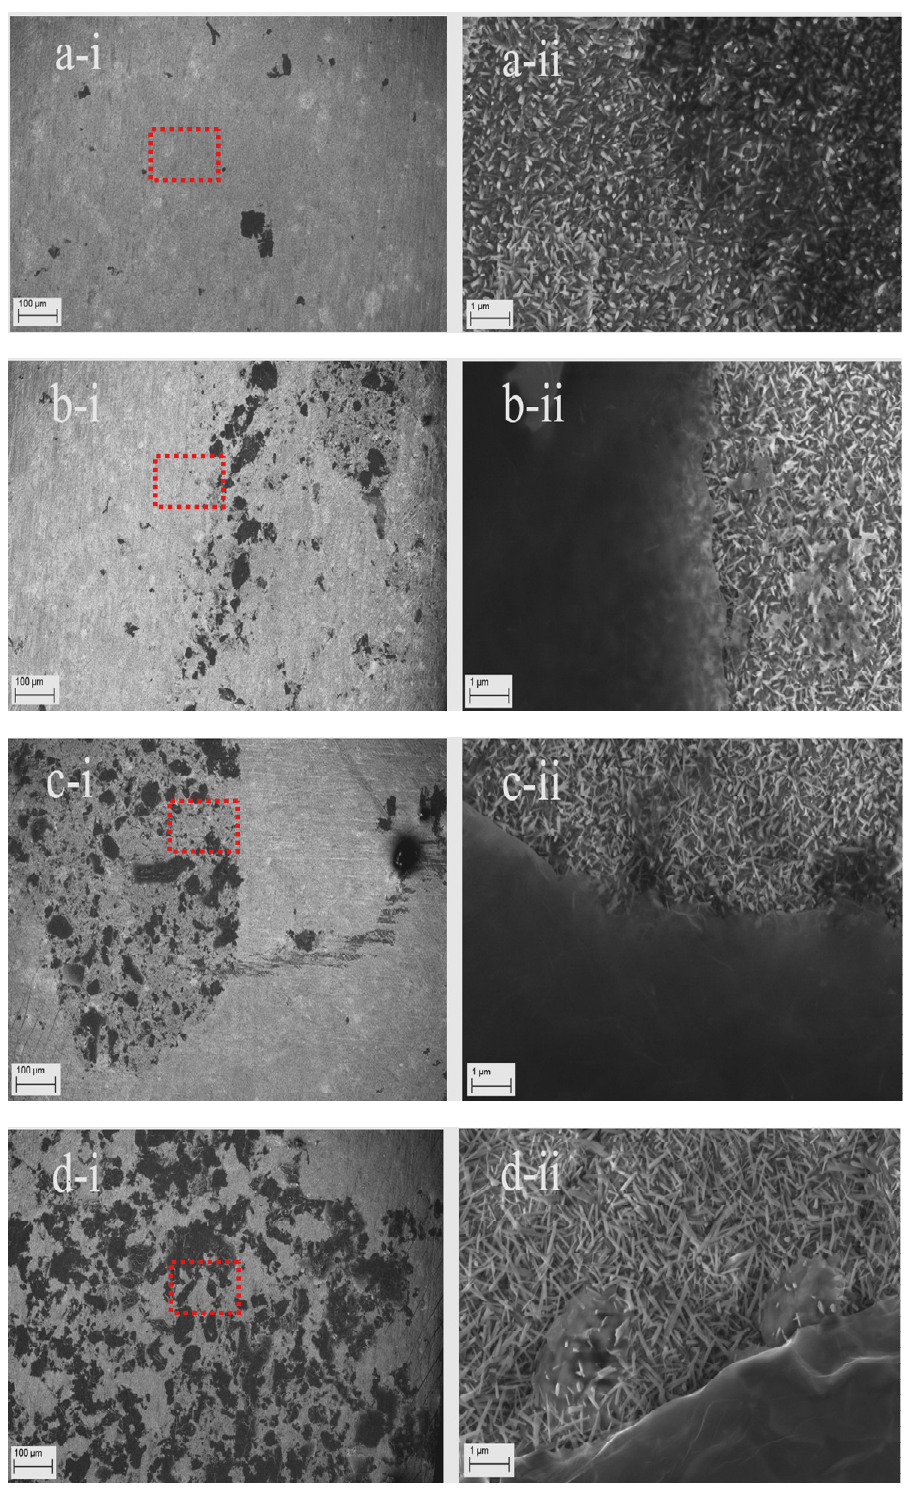
Figure 2. FESEM images of GO deposited on TNWs using EPD with different deposition times: ( a ) 10 s; ( b ) 30 s; ( c ) 1 min; and ( d ) 5 min. Low-magnification images: left side (( a - i ) to ( d - i )) and high-magnification images: right side (( a - ii ) to ( d - ii )).